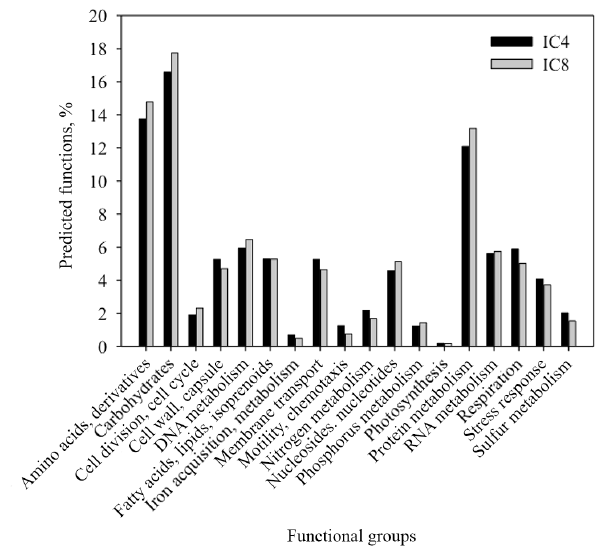
Figure 3. Percentage of gene sequences associated with different functions in the annotated protein sequences within IC4 and IC8 metagenomes.